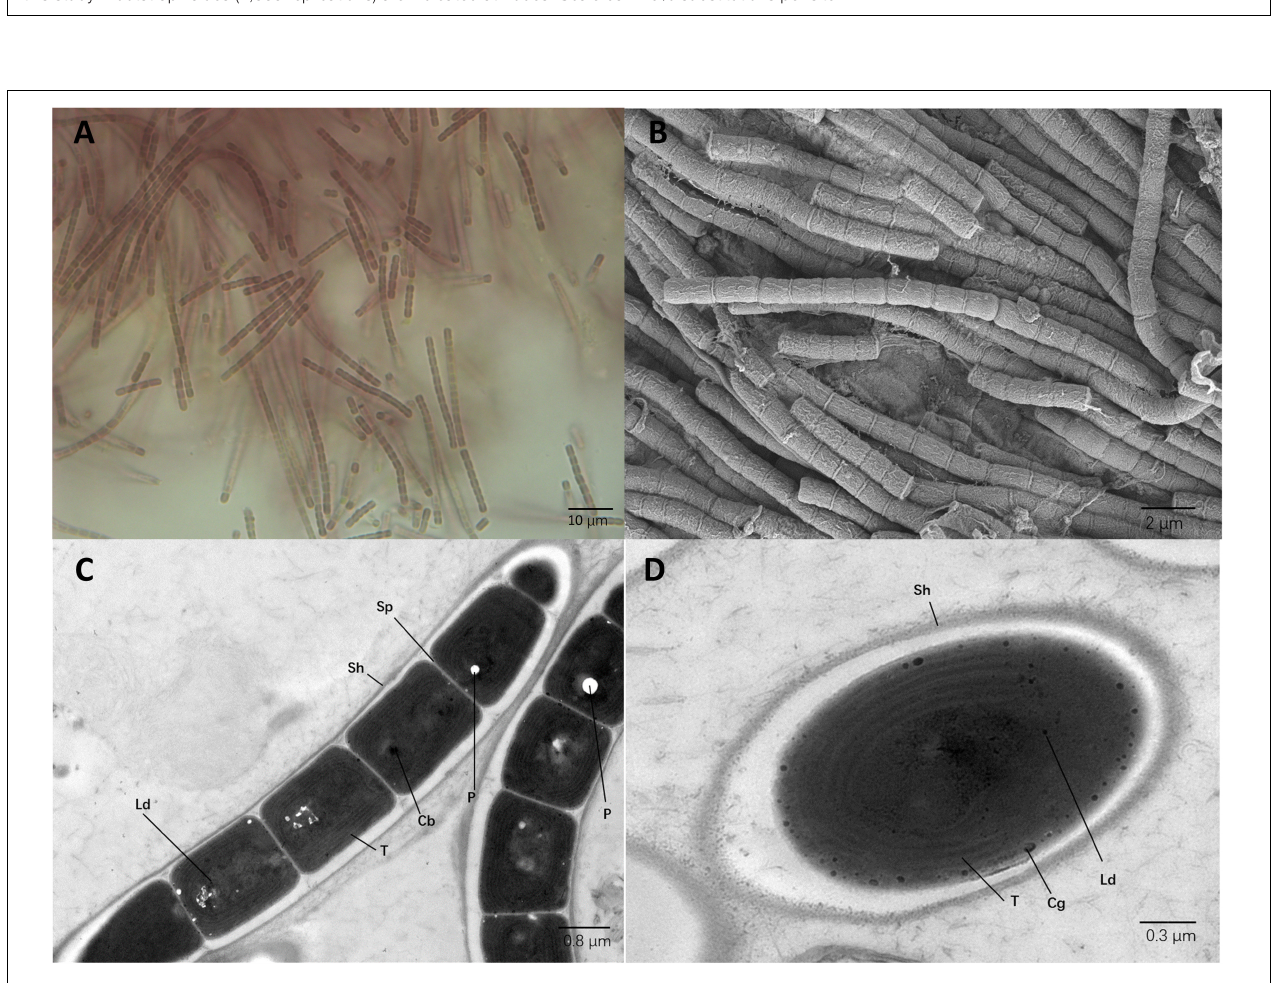
FIGURE 4 | Micrographs of strain E412. (A) Light microscopy image. (B) SEM image. (C,D) TEM images. Cb, carboxysome; Cg, cyanophycin granule; Ld, lipid droplet; P, polyphosphate body; Sh, sheath; Sp, septum; T, thylakoid membrane. Magnifications were 1,000 × (A) , 5,000 × (B) , 8,000 × (C) , and 12,000 × (D) .